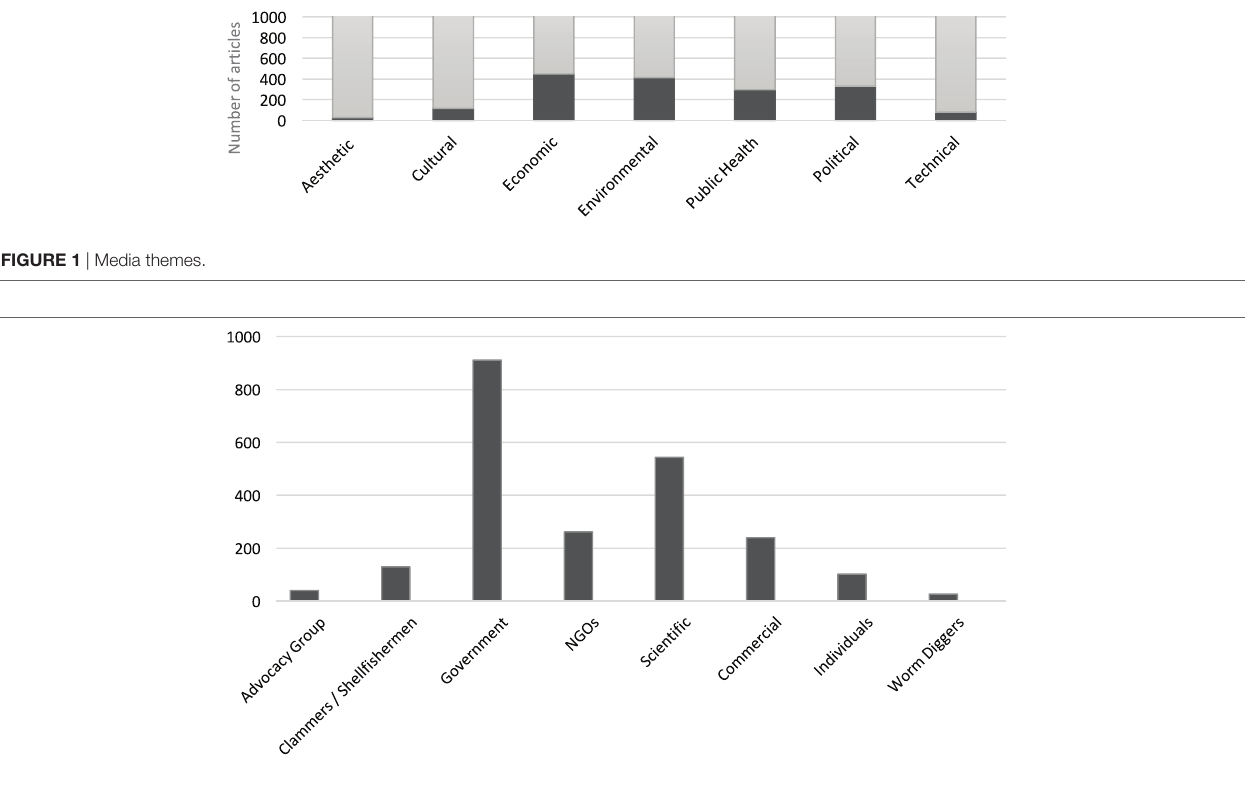
FigUre 2 | Expertise.